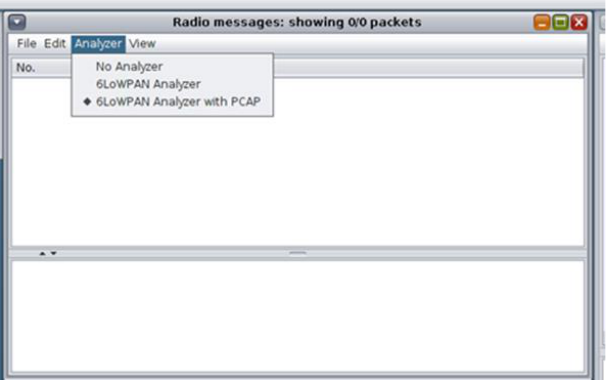
Figure 14. “Radio messages” tool—output window.